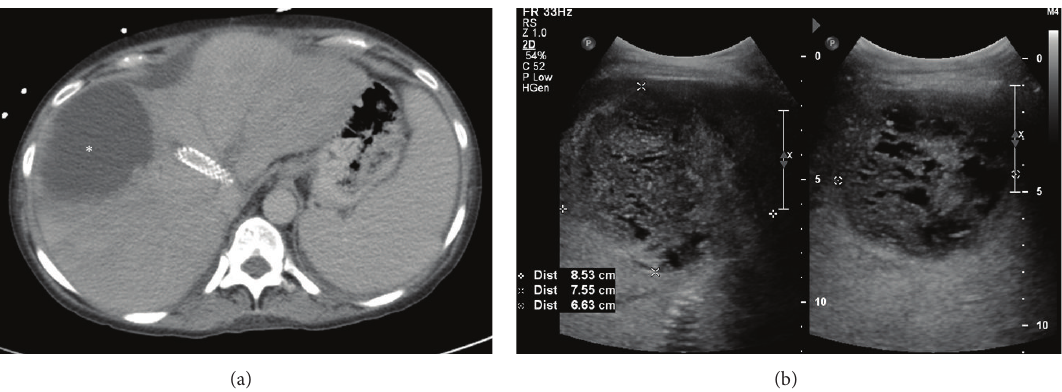
Figure 4: (a) Axial contrast-enhanced CT of the upper abdomen shows a well-defined nonenhancing hypodense area liquefaction necrosis of infarcted liver parenchyma in hepatic segments V and VIII ( asterisk ). Again noted is the hypodense material within the left hepatic vein, consistentwithhepaticveinthrombosis.(b)Ultrasoundoftherightlobeoftheliverdemonstratesaheterogeneouscollectionthatcorresponds to hepatic